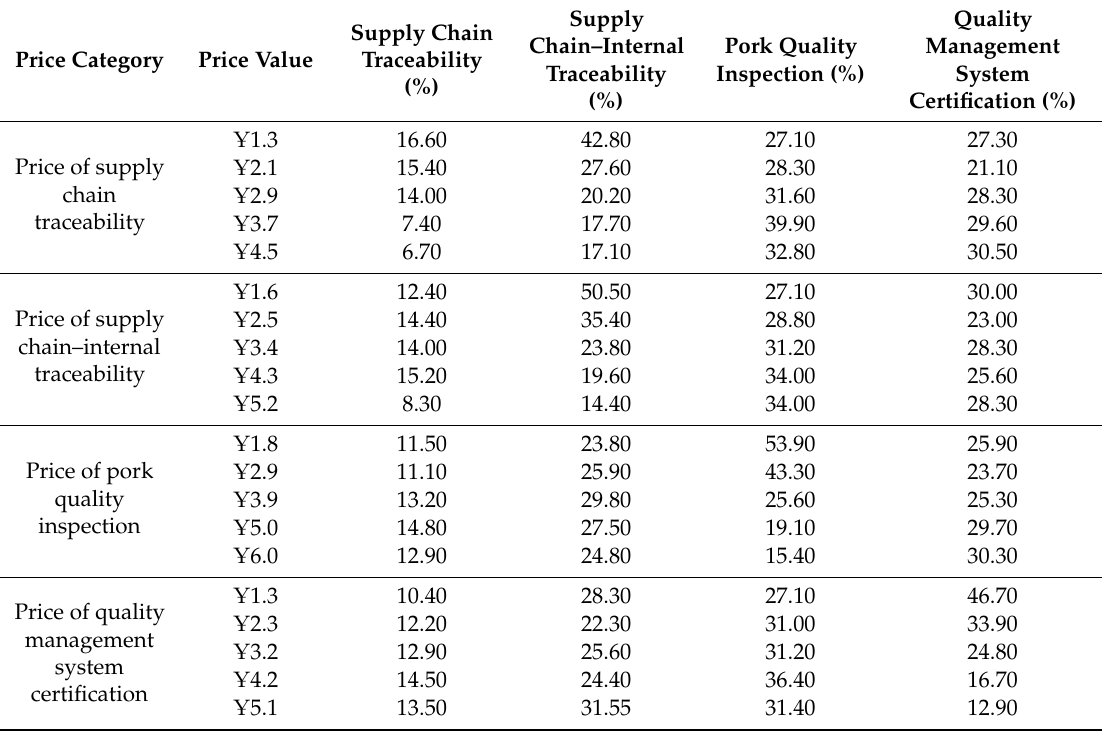
Table 8. Frequency of choice for each attribute at di ff erent price